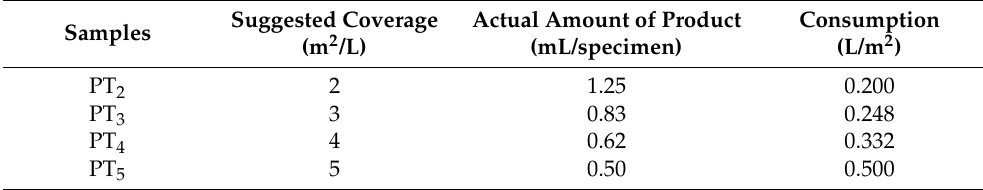
Table 1. Details of the treatments for the evaluation of the optimal amount of product.